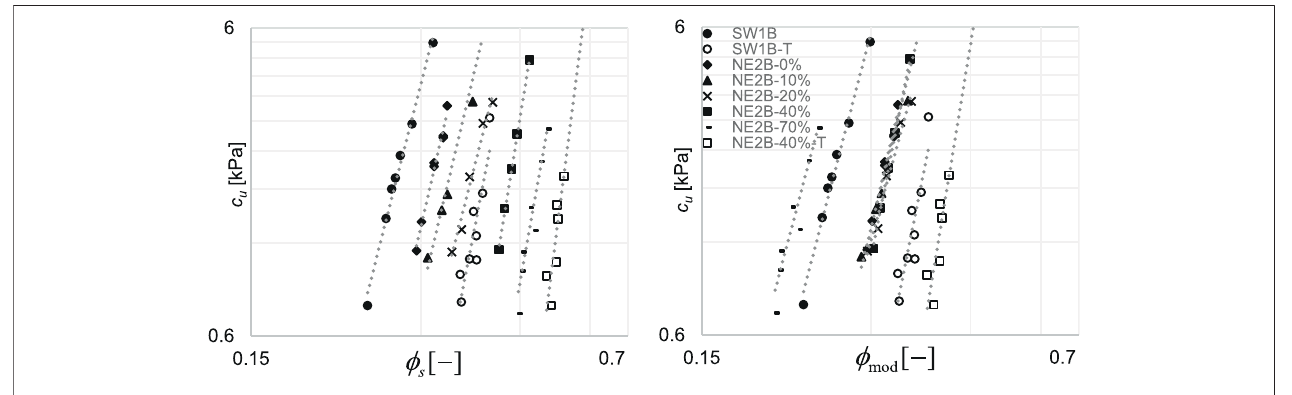
FIGURE 2 | Undrained shear strength as a function ϕ s (left) and ϕ mod